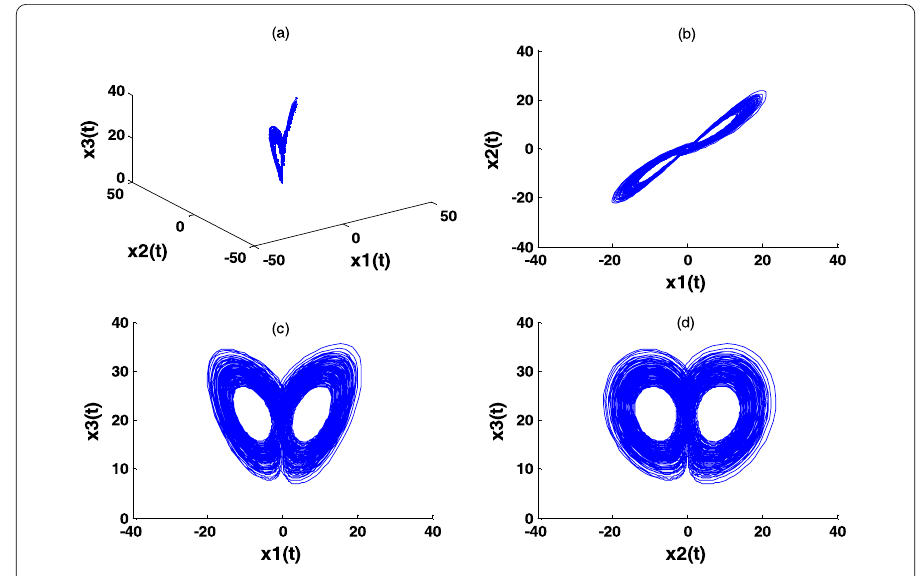
Figure 1 Chaotic attractors of the fractional-order unified system: ( a ) plot in the ( x 1 , x 2 , x 3 )-space; ( b ) plot in the ( x 1 , x 2 )-plane; ( c ) plot in the ( x 1 , x 3 )-plane; ( d ) plot in the ( x 2 , x 3